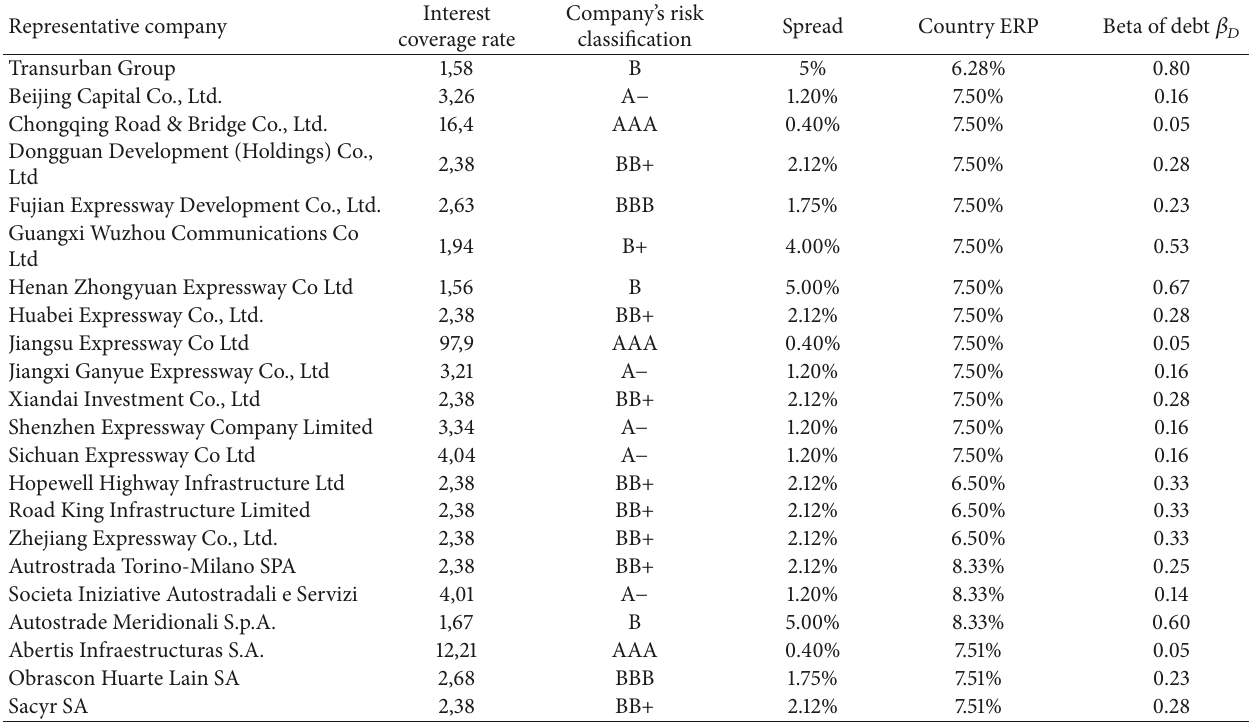
Table 3: Betas of debt for representative companies ( 𝛽 𝐷